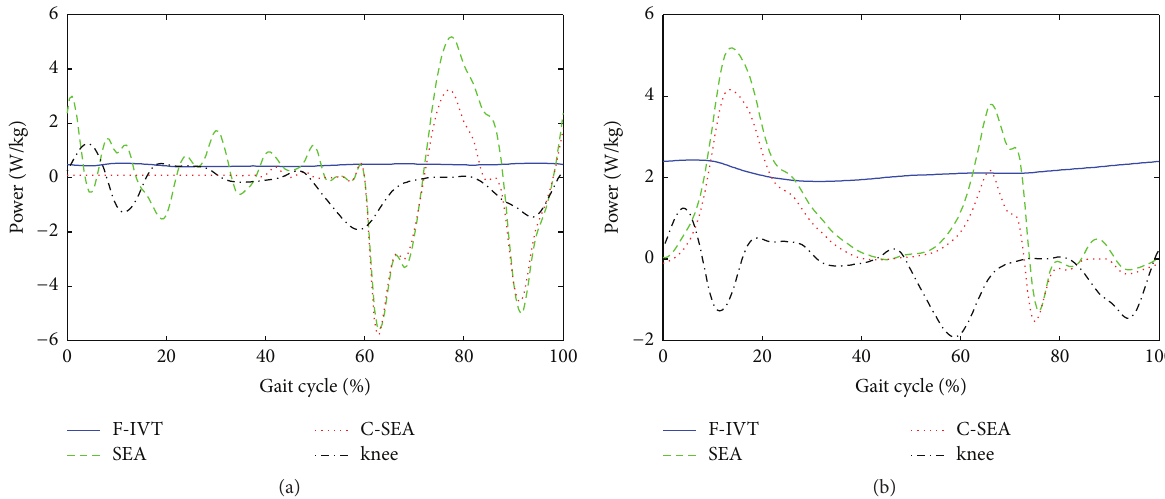
Figure 9: Instant power requirements of the knee joint and of the electric motor of the actuators compared (F-IVT, SEA, and C-SEA) in level ground walking at 2.1 m/s (a) and in stairs climbing at inclination of 30 ∘ (b).